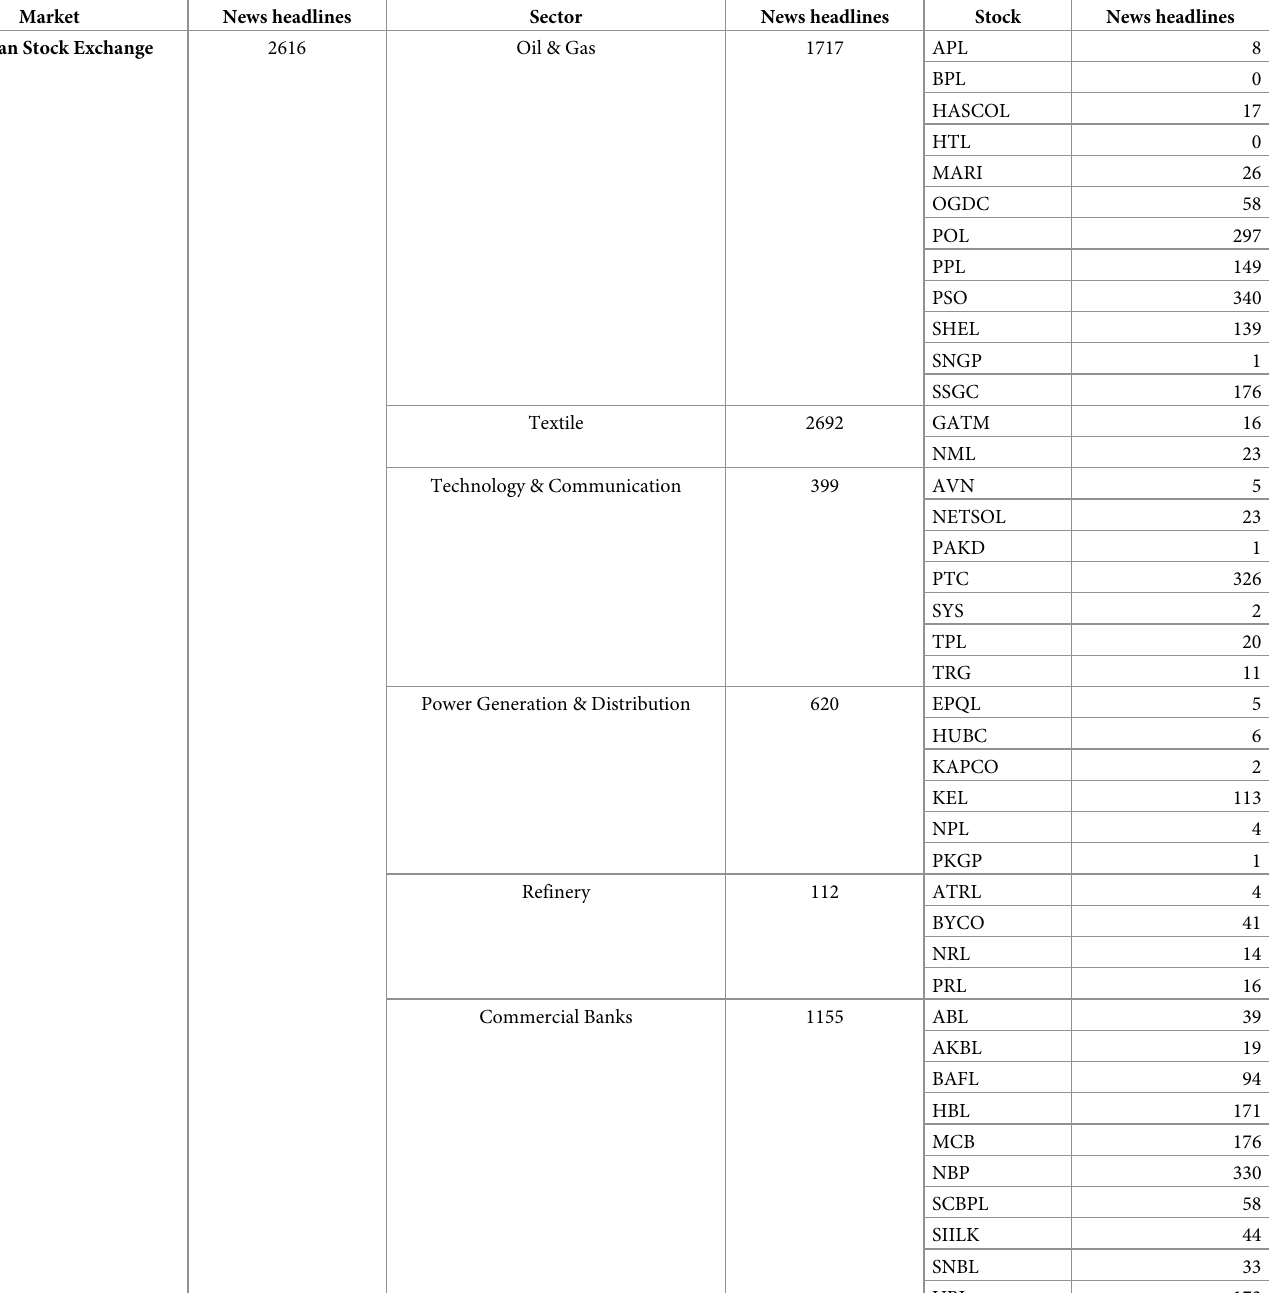
Table 2. Number of news headlines in news